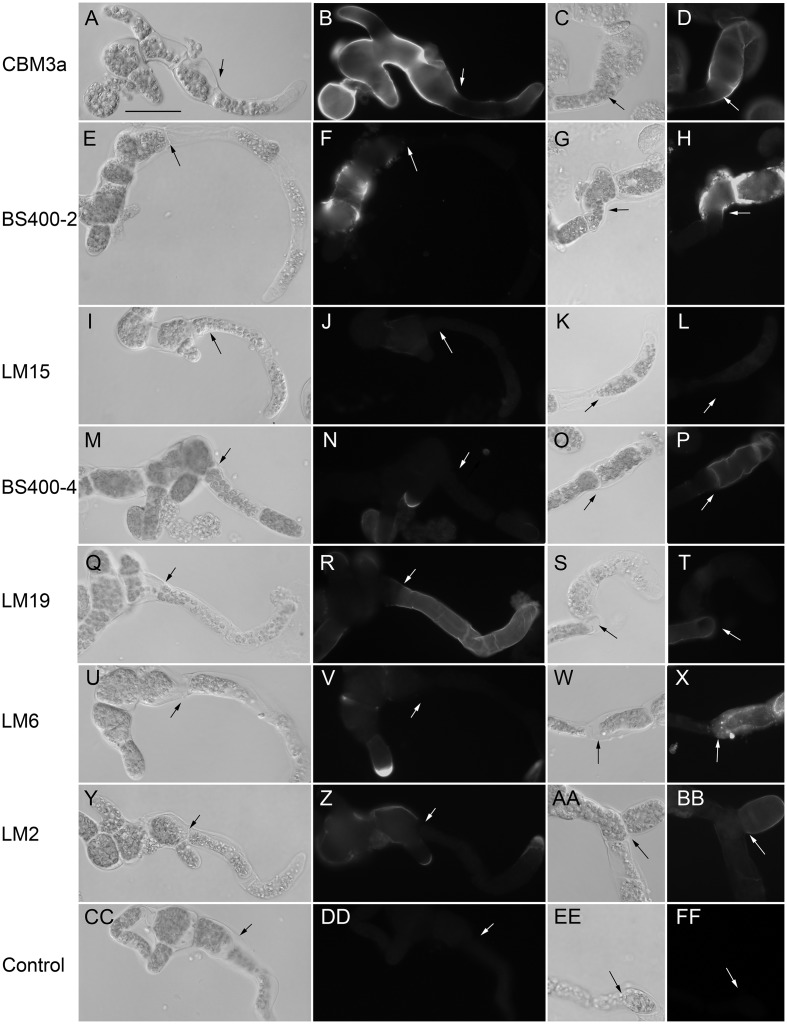
Physcomitrella patens protonemal filaments regenerated from protoplasts and labeled with antibodies or CBMs. Protoplasts were fixed after regeneration on medium containing mannitol for 2 days and growth on mannitol-free medium for 2 days (columns 1 and 2) or after the same treatment followed by two additional days growth on medium containing mannitol (columns 3 and 4). Colonies were imaged with DIC optics (columns 1 and 3) or fluorescence optics (columns 2 and 4) after labeling with (A–D) CBM3a for crystalline cellulose, (E–H) anti-callose (BS-400-2), (I–L) anti-xyloglucan (LM15), (M–P) anti-mannan (BS-400-4), (Q–T) anti-HG (LM19), (U–X) anti-1,5-α-L-arabinan (LM6), (Y–BB) anti-arabinogalactan protein (LM2) or no primary antibody (CC–FF). Arrows indicate the transition between cells that developed from protoplasts on mannitol-containing medium (left) and cells that developed on mannitol-free medium (right) in column 1 and 2 and between cells that developed on mannitol-free medium (left) and after transfer to mannitol-containing medium (right) in columns 3 and 4. Bar = 50 μm.